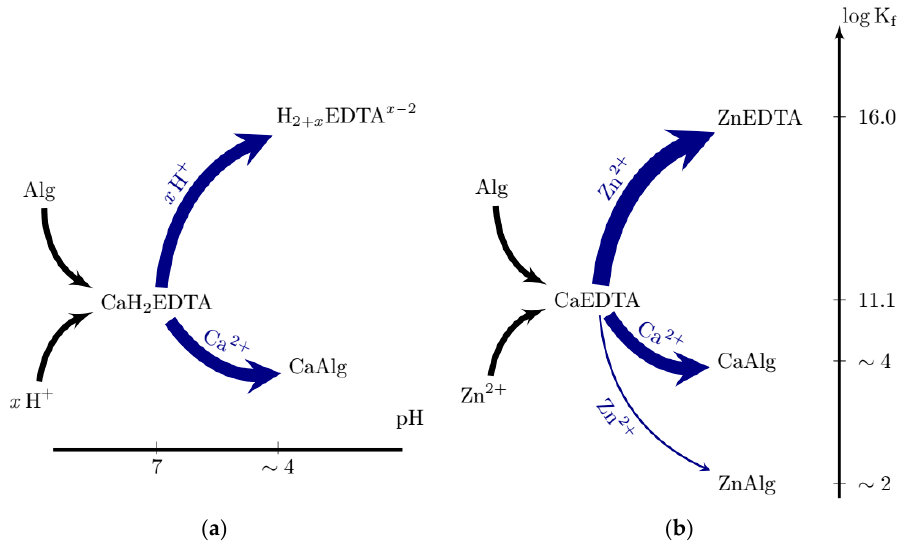
Figure 1. Schematic illustration of exchange reactions employed for ionic gelation of alginate when using the combination of CaEDTA and an acidifying agent, typically glucono δ -lactone (GDL) ( a ), and the competitive ligand exchange reaction, CLEX for the CaEDTA–Zn(EDDA) gelation ion chelator and exchange ion chelator pair ( b ).